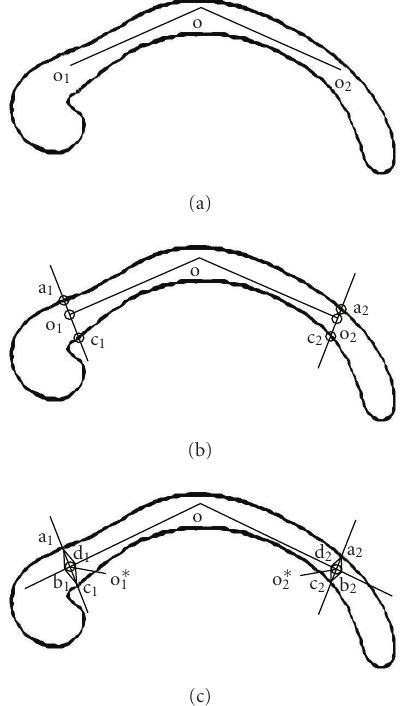
Figure 2: Illustration of the seed initialization process. (a) User- initialized polyline. (b) Point tracing. (c) Completed seed contour.